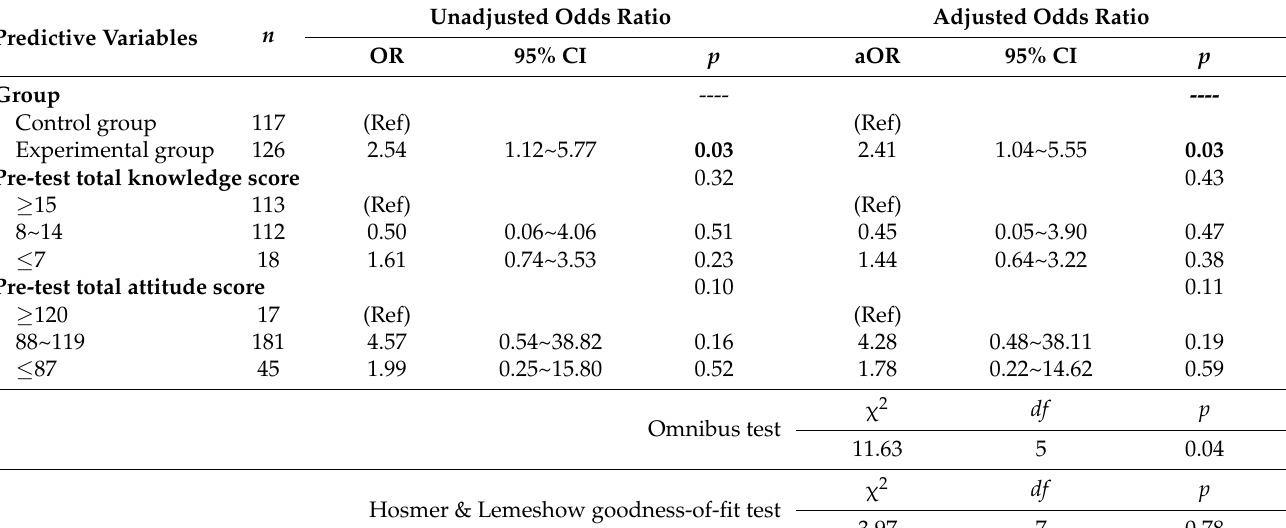
Table 4. Multiple logistic regression analysis for positive change in vaccination intention among pregnant